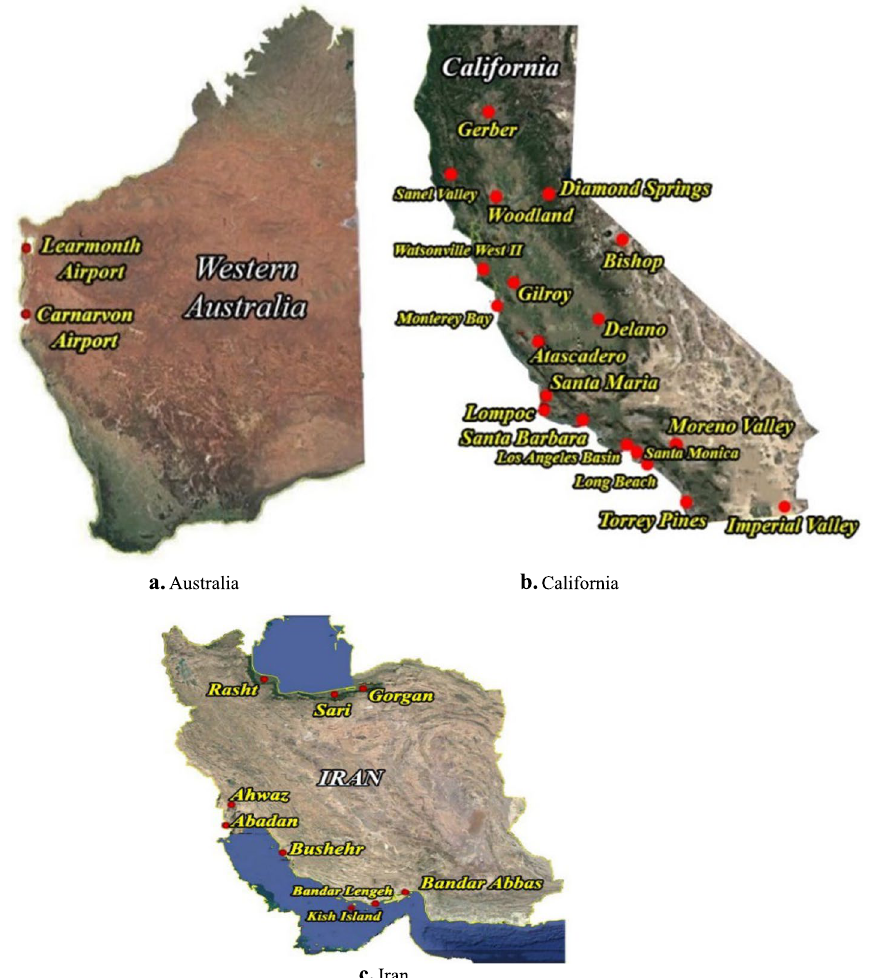
Fig. 2 The location of case studies. a Australia. b California. c